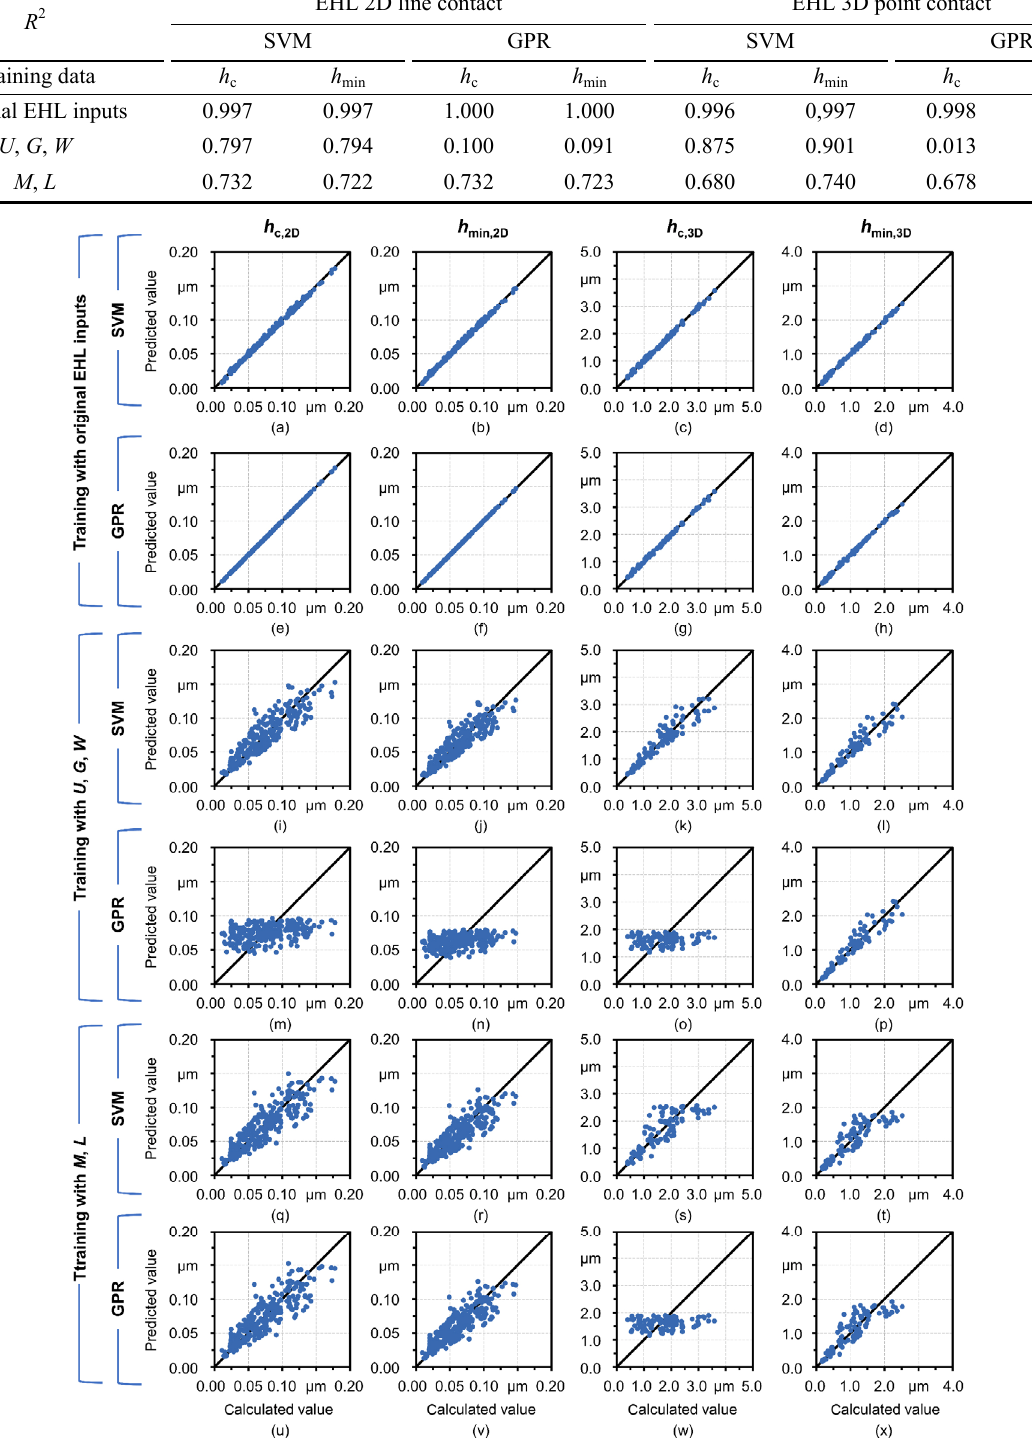
Fig. 7 Predicted versus calculated values (testing data) of the central and minimum film thicknesses for the infinite 2D line and 3D circular point contacts using (a–d, i–l, q–t) SVM and (e–h, m–p, u–x) GPR trained with (a–h) the original EHL inputs, (i–p) the non-dimensional parameters U , G , W , or (q–x) M , L